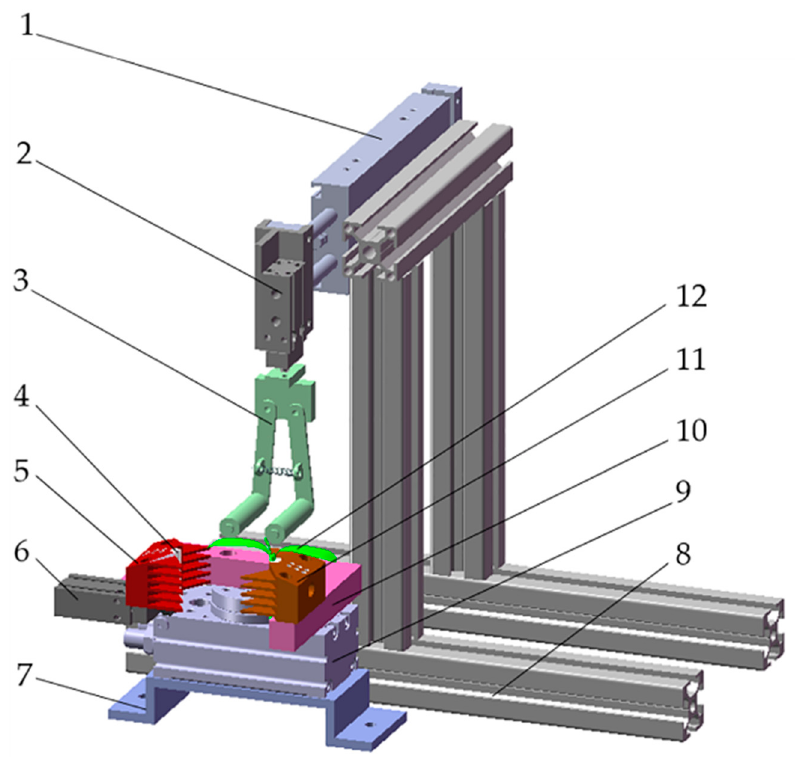
Figure 3. 3D model of rootstock clamping device. 1. Pneumatic cylinder “a”. 2. Pneumatic cylinder